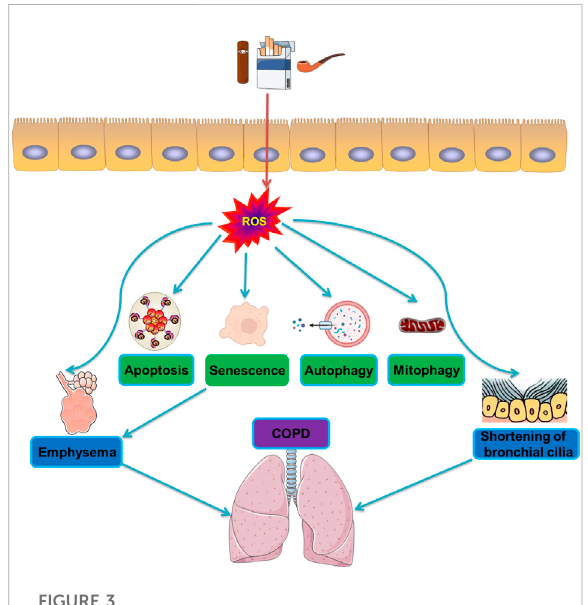
FIGURE 3 Molecular mechanisms of autophagy during oxidative stress in COPD. CS induces activation of oxidative stress and production of reactive oxygen species ROS. The generation of ROS then triggers the formation of apoptosis and senescence, and degradation of autophagy and mitophagy, leading to emphysema and shortening of bronchial cilia, and ultimately induces